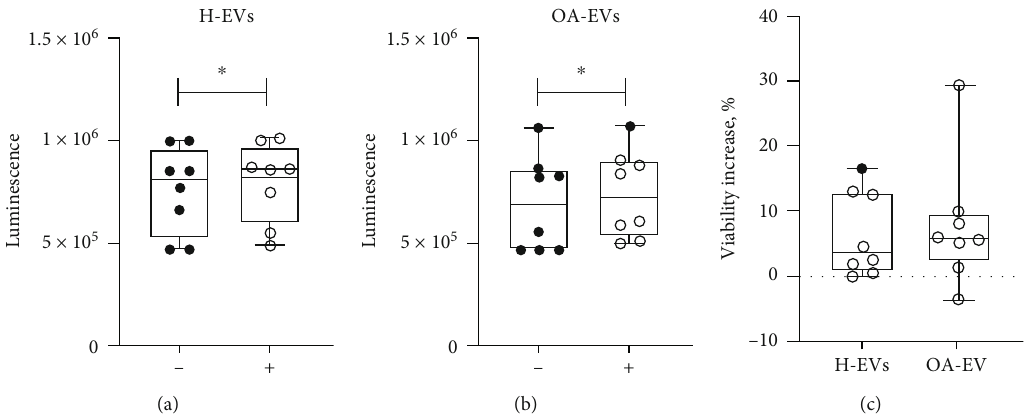
Figure 2: The e ff ect of EVs on chondrocyte viability in CellTitter-Glo assay. (a) Viability of chondrocytes measured in luminescence units when treated with H-EVs (+), compared with untreated OA chondrocytes (-). (b) Viability of chondrocytes when treated with EVs from OA-MSCs (+), compared with untreated chondrocytes (-). (c) Percentage increase in viability above the untreated controls between H- EVs and OA-EVs. Horizontal bars show medians, and whiskers represent min to max. ∗ p value < 0.05. Paired t -test